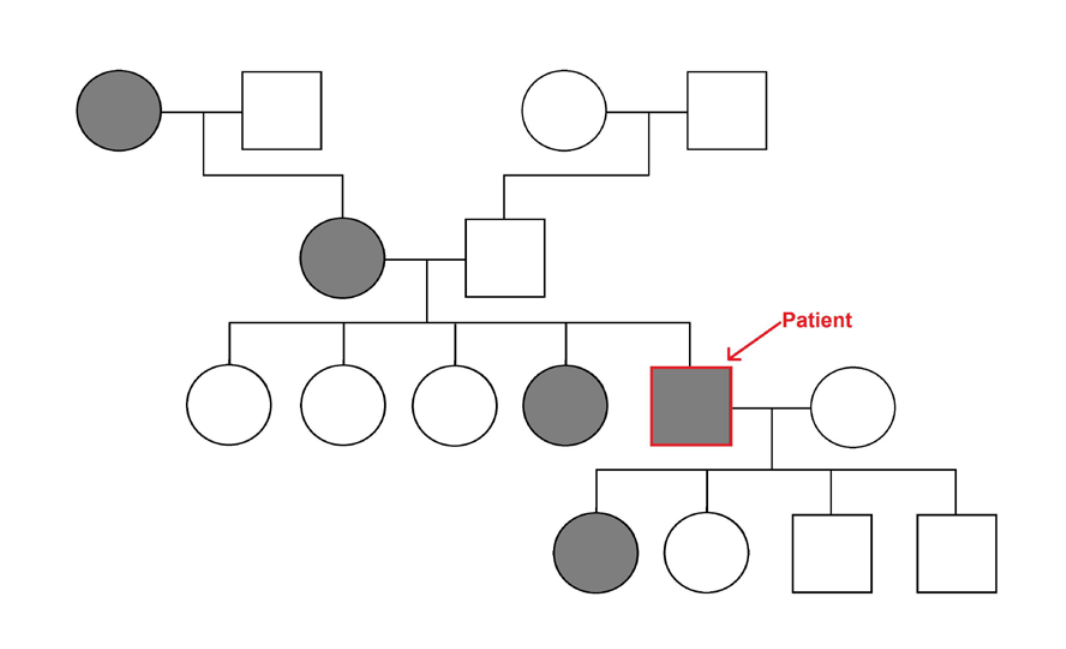
Figure 1: Pedigree of the